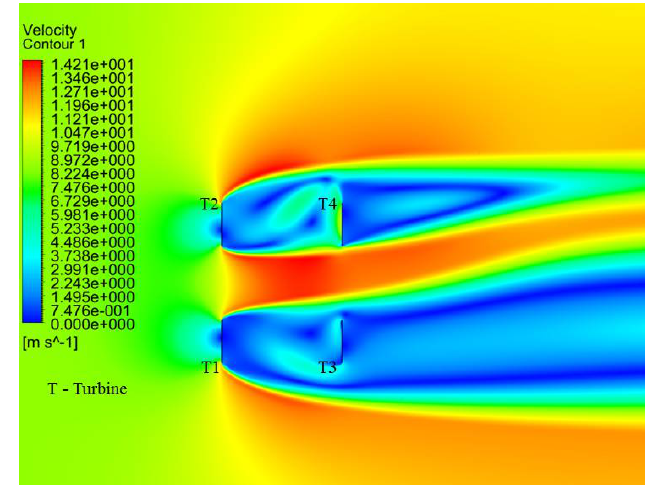
Figure 8. Discretized model of the pentagon configuration.